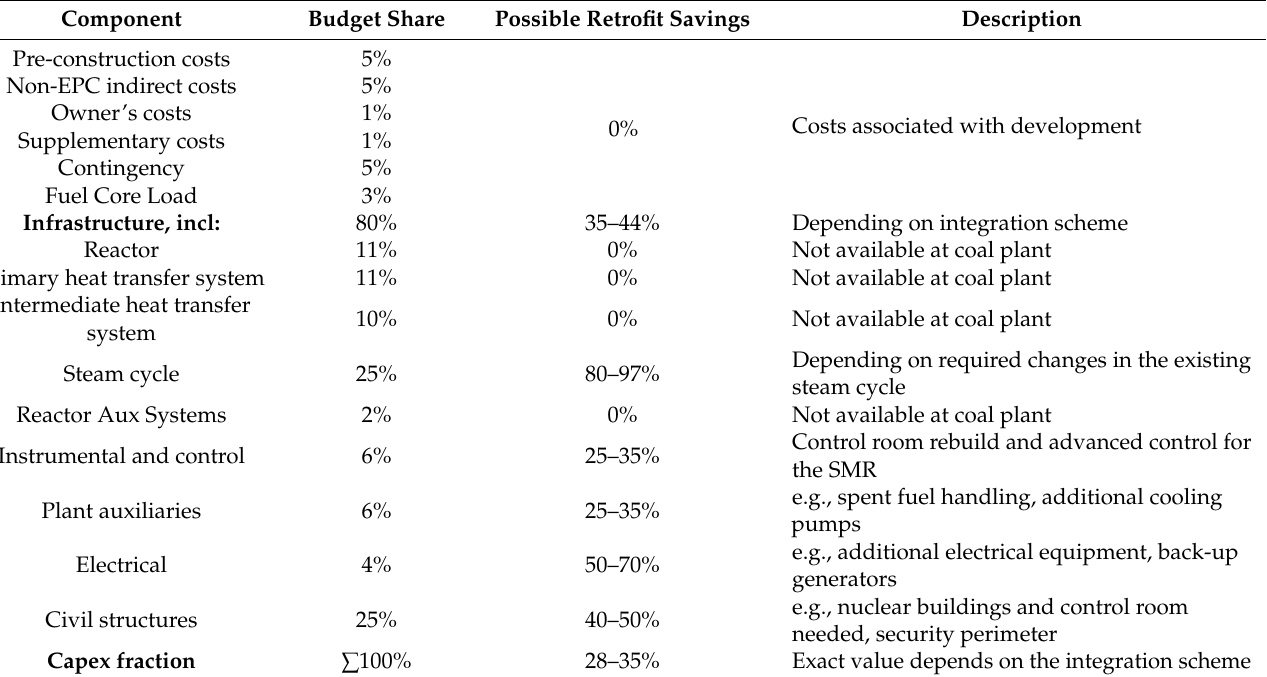
Table 9. Assumed overnight capital cost breakdown of an advanced high-temperature